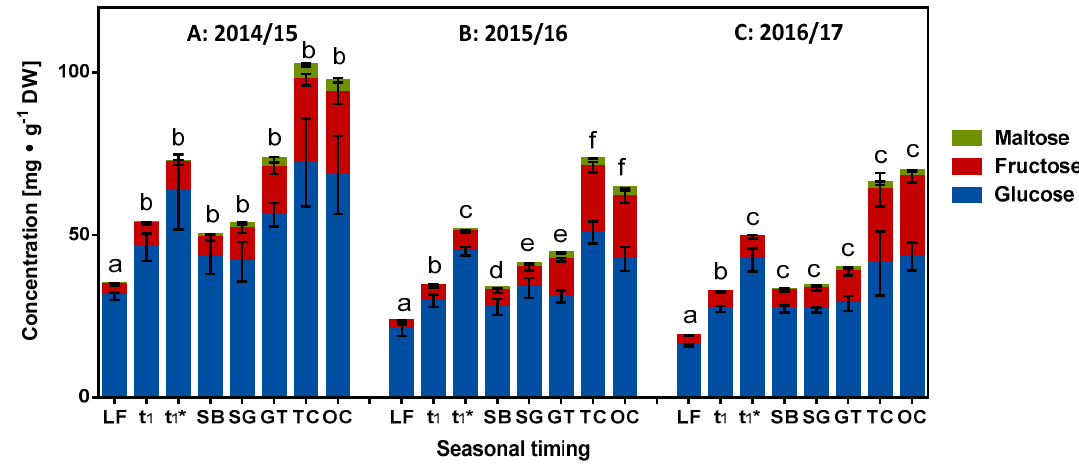
Figure 5. Composition of the reducing sugars at the different developmental milestones as determined by HPLC. ( A ) Season 2014/15; ( B ) Season 2015/16 and ( C ) Season 2016/17. Abbreviations: LF, leaf fall; t 1 = endodormancy release, t 1 * = beginning of ontogenetic development, SB = swollen bud, SG = side green, GT = green tip, TC = tight cluster, OC = open cluster; DW, dry weight. Different small letters in each season (a–f) indicate significantly different mean values of the total reducing sugars from the previous or subsequent values (Tukey‘s multiple comparisons test, p ≤ 0.05, n = 4) for each milestone.